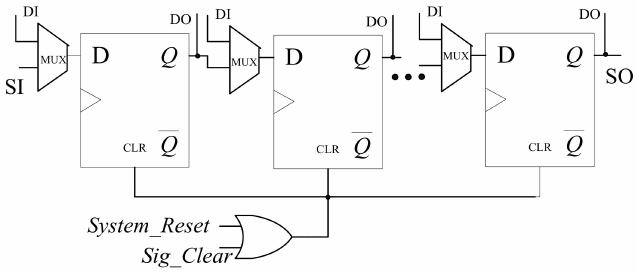
Figure 6. Aided resetting logic.